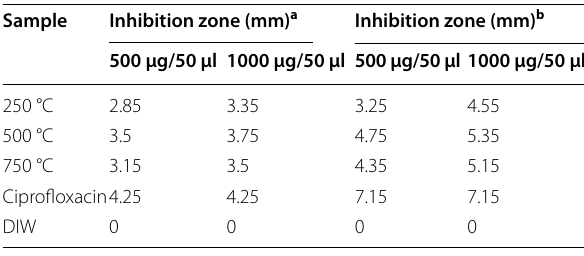
a Zones of inhibition (mm) of fabricated products for E. coli b Attained nanostructures inhibition zones for S.